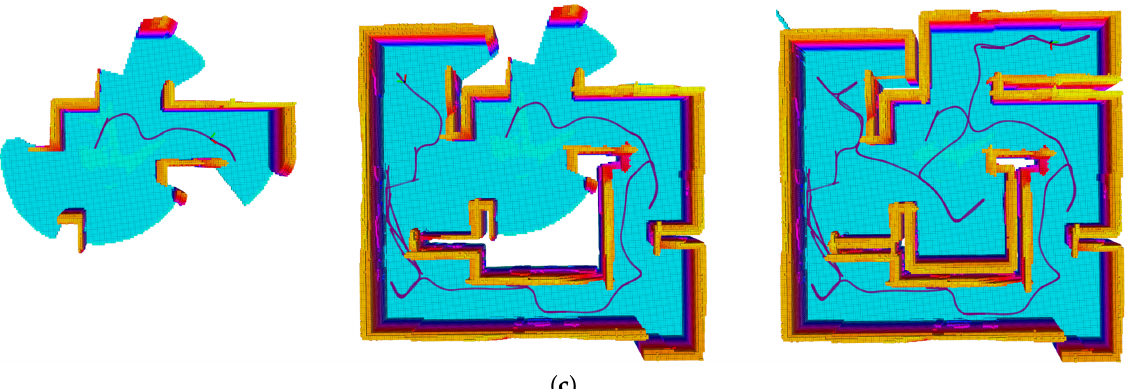
Figure 9. Exploration in maze scenario, the three utility formations are compared, the color of the grid changes from blue to red as the height increases. ( a ) Exploartion using linear utility. ( b ) Exploartion using exponential utility. ( c ) Exploartion using normalized utility.